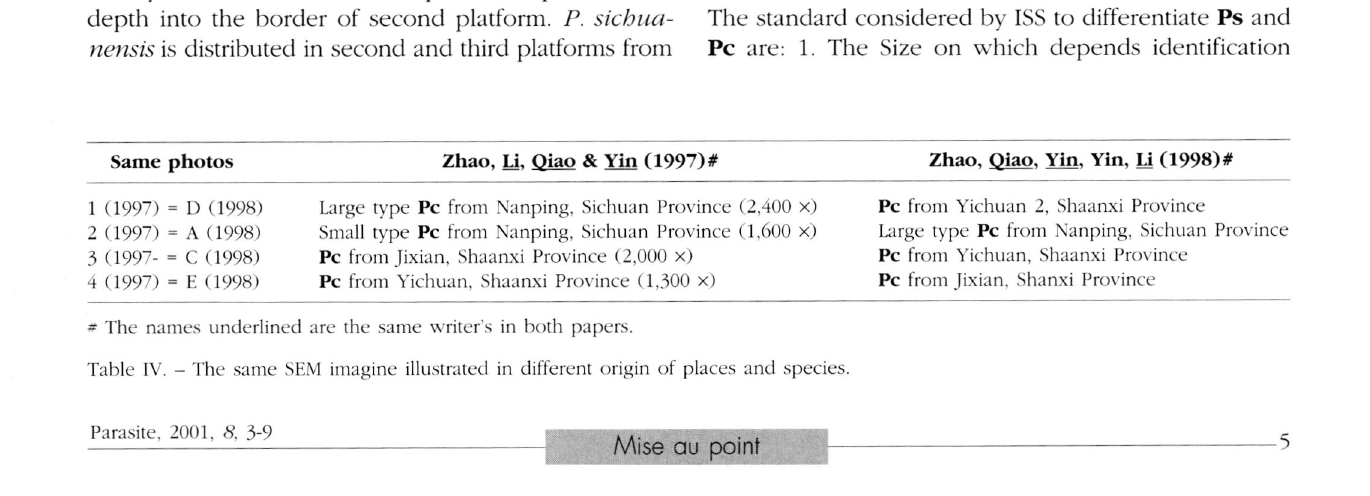
Parasite. 2001, 8,